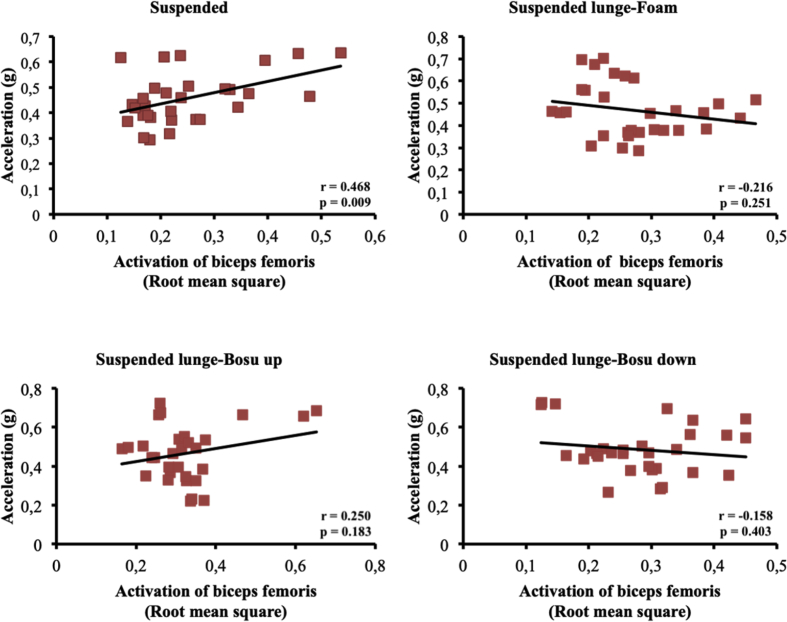
Correlation between biceps femoris activation and acceleration values under suspended lunge conditions.